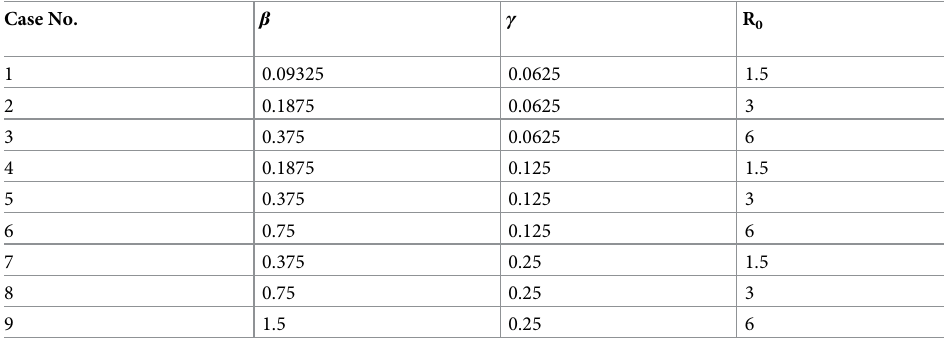
Table 1. Values of β , γ , and R 0 in nine